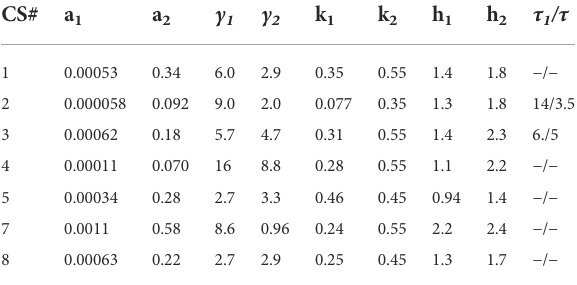
TABLE 5Parametersdeterminedfrom fi tting the hysteresisModel 2to datafromCSsubjects.Theparametersobtainedaresimilartothat for Hill Model 1. The values of h 1 are lower than h 2 in all subjects implying a steeper glucose dependent dose-response during the insulin recovery phase.